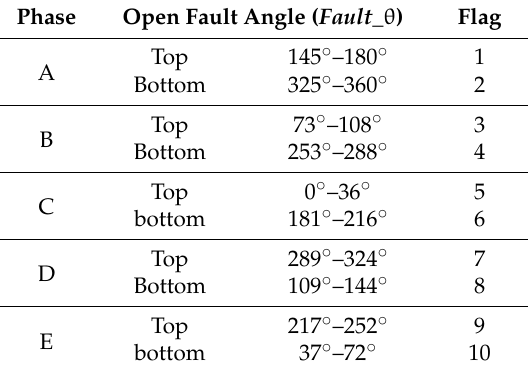
Table 1. Detected phase angles of each switching devices under the open ‐ fault condition.